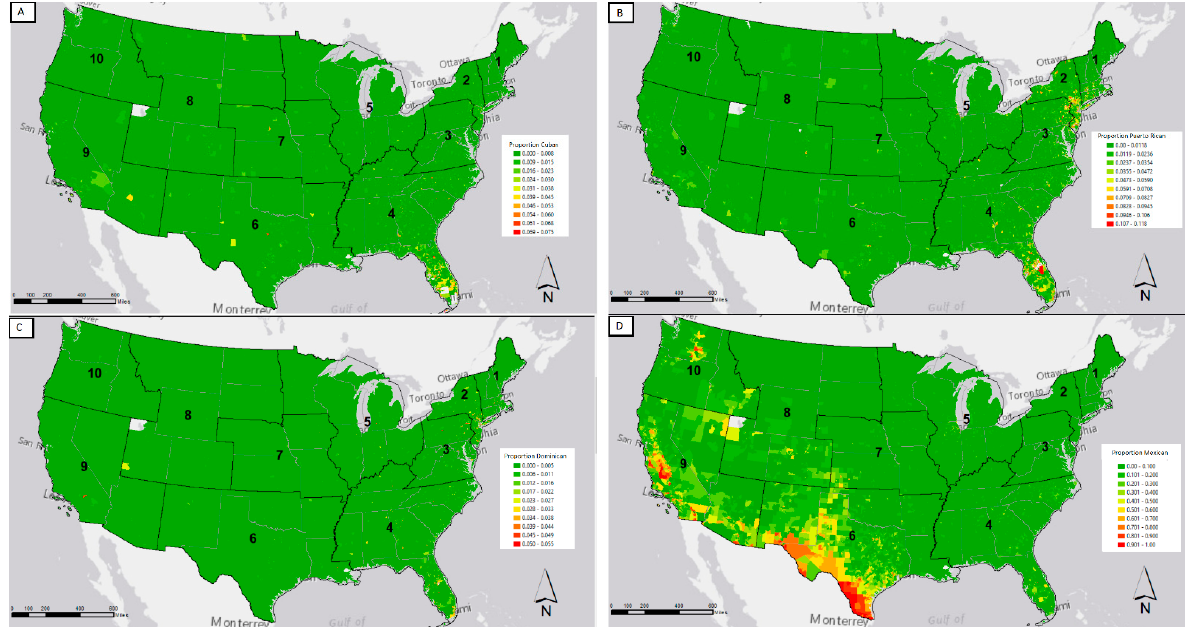
Figure 1. Map of proportion of census tract for four Latino ethnic groups, broken down by decile; ( A ) Proportion of Cuban population; ( B ) Proportion of Puerto Rican population; ( C ) Proportion of Dominican population; ( D ) Proportion of Mexican population.